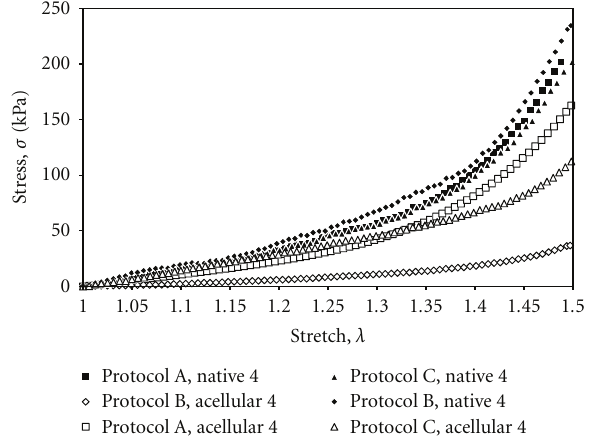
Figure 6: Typical final experimental load curves for native and acellular samples across all decellularization protocols